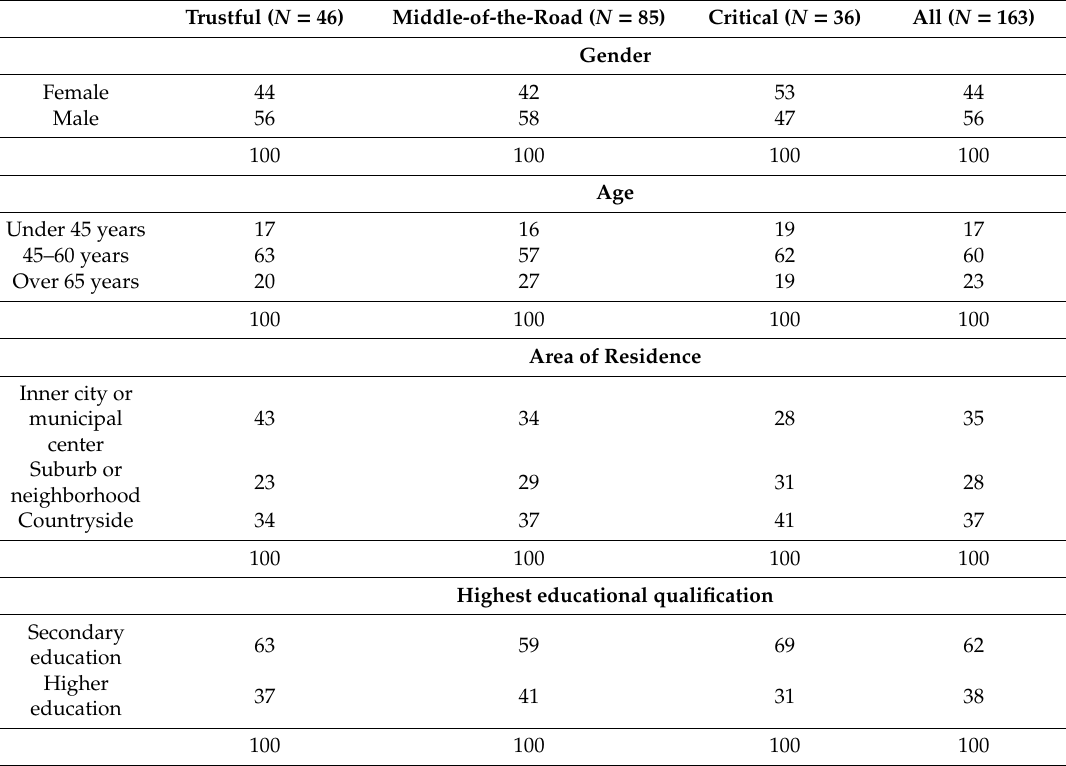
Table 1. Demographic factors of the three groups